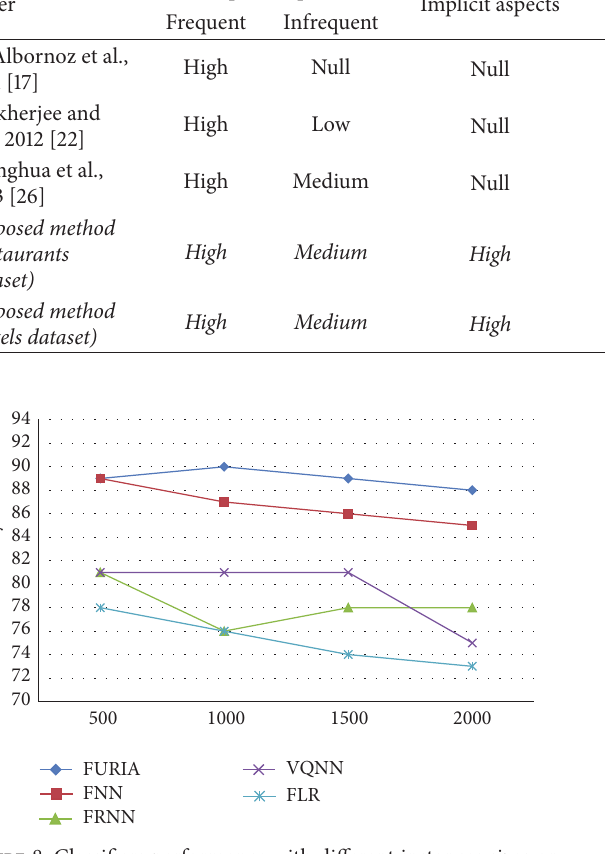
Figure 8: Classifiers performance with different instances sizes on restaurants dataset.